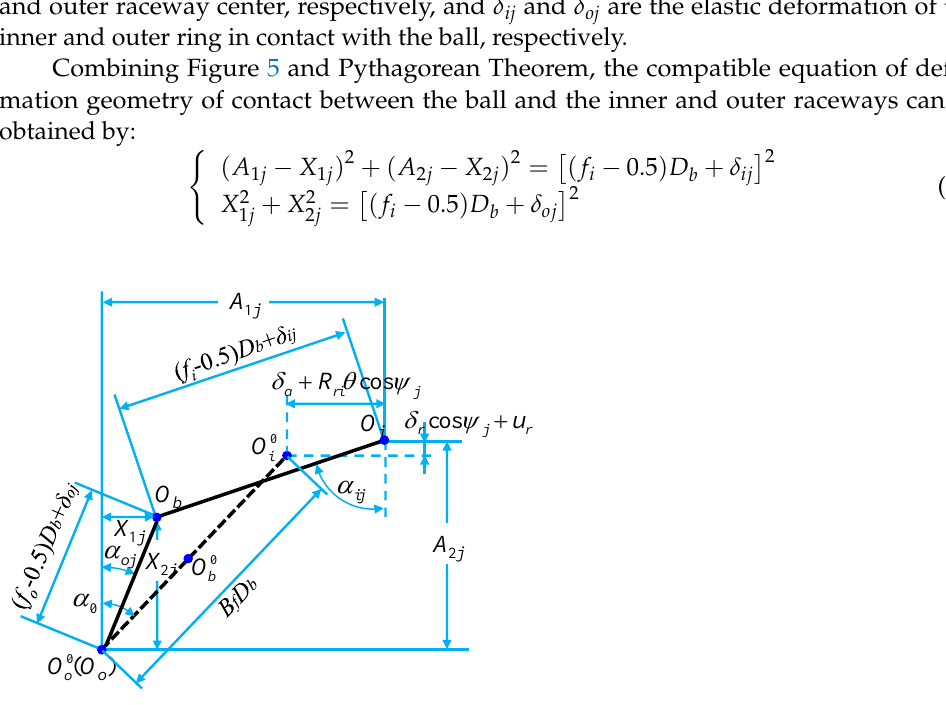
Figure 5. The contact angles, deformations, and displacements for the ball – raceway contacts at azimuth ψ j with the working load and centrifugal force.